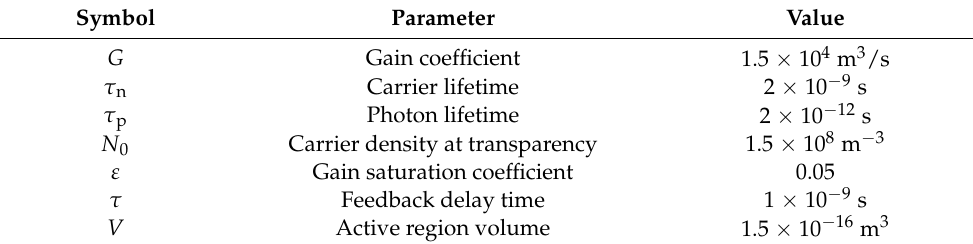
Table 1. Parameters and values. Table 1.